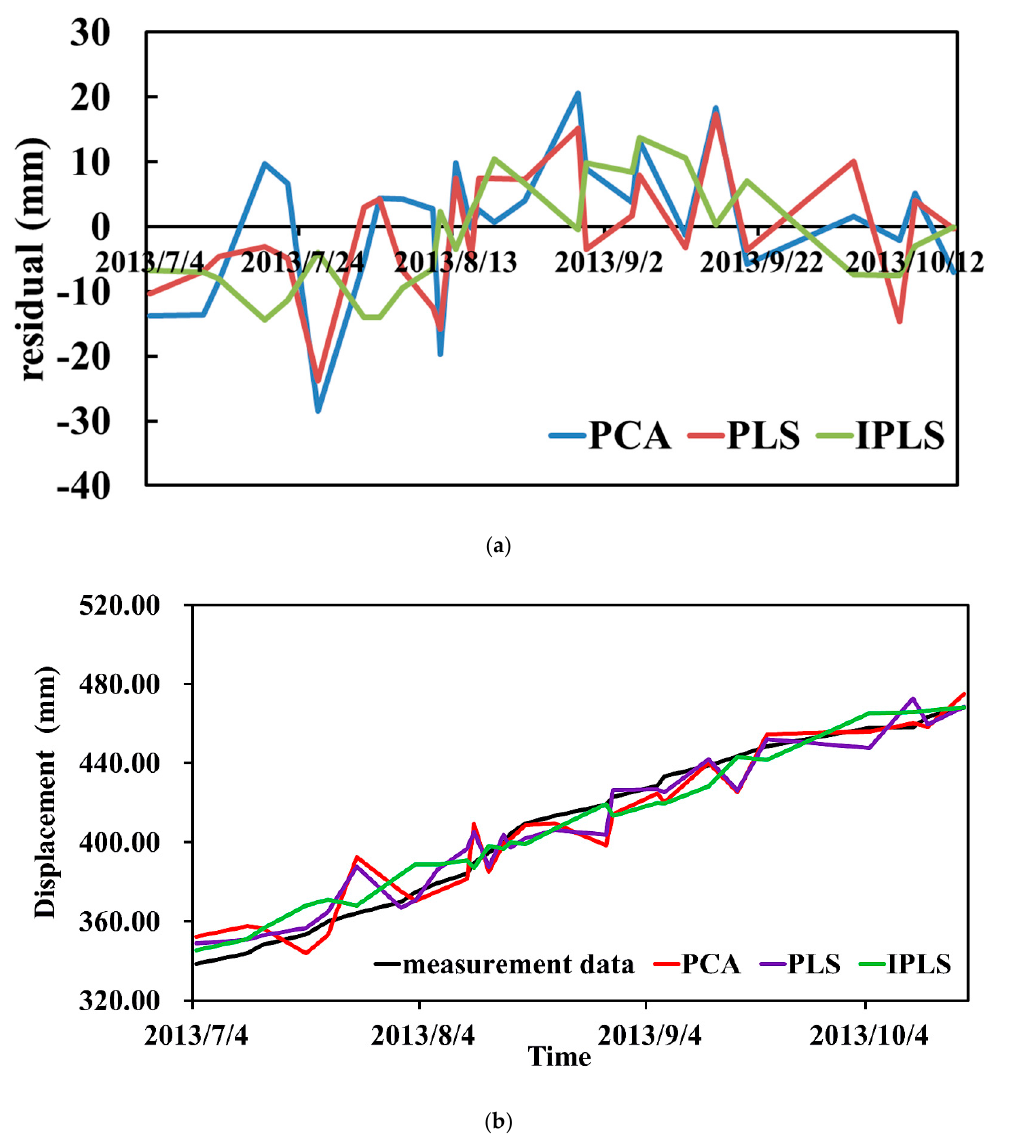
Figure 10. ( a ) Residual comparison diagram; ( b ) Comparison of measured data with the results calculated by the PCA, PLS, and IPLS methods.